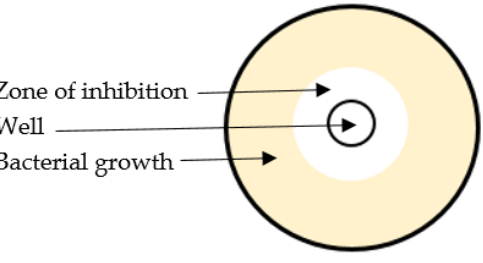
Figure 4. Schematic representation of agar diffusion method.